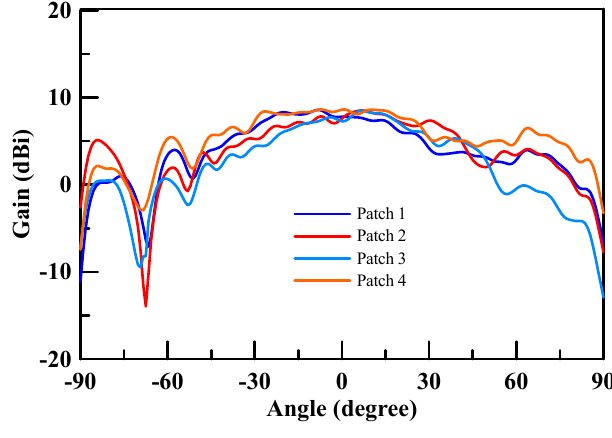
Figure 18. Single patch antenna gain (X-cut).